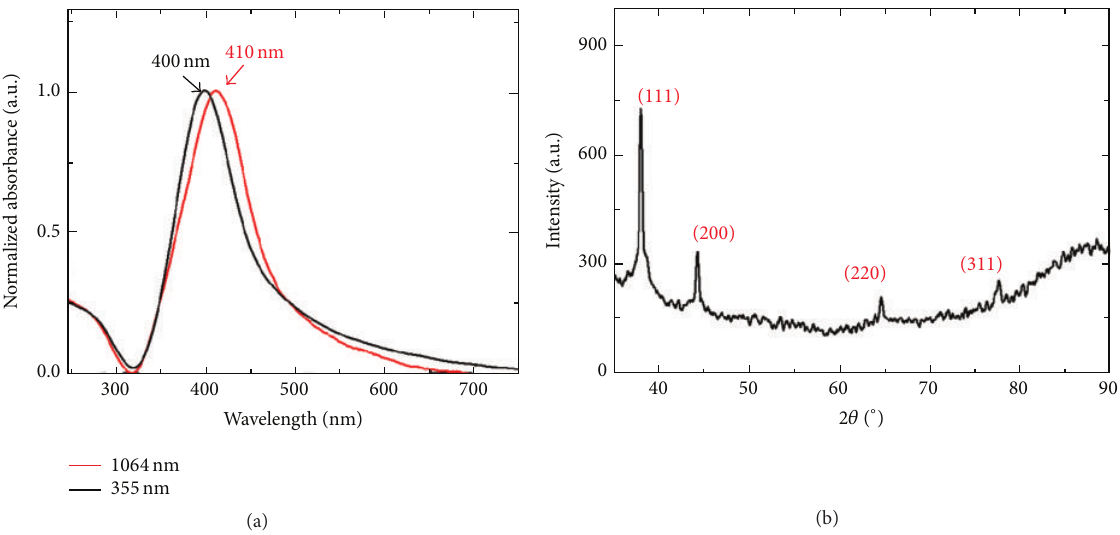
Figure 3: (a) UV-Vis absorption spectra of the ligand-free Ag colloidal solution produced via picosecond laser ablation of a silver target in deionized water using different laser wavelength, sample A: 1064nm and sample B: 355 nm. (b) XRD pattern of the ligand-free Ag NPs ( 𝑑 = 20 nm) produced via picosecond laser ablation of a silver target in deionized water. Ag NPs exhibit the (111), (200), (220), and (311) main peaks of cubic Ag